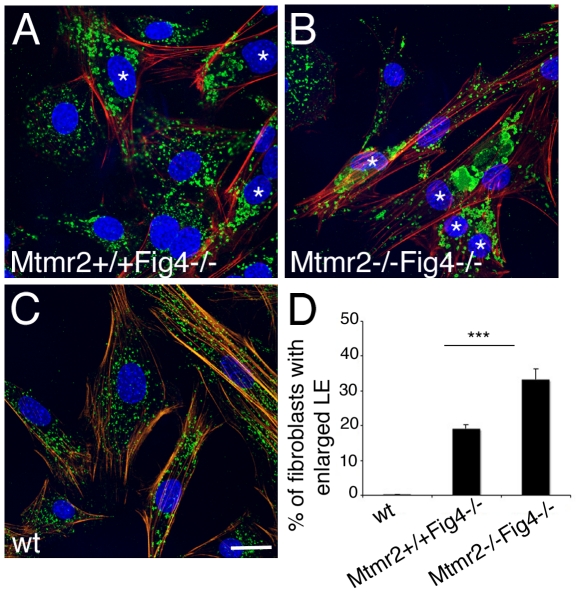
Enlarged late endosomal compartment in primary fibroblasts from Mtmr2+/+Fig4−/− and Mtmr2−/−Fig4−/− mutant mice.(A–C) The number of fibroblasts carrying enlarged late endosomal/lysosomal compartment (LAMP1 positive, green) is significantly increased in Mtmr2−/−Fig4−/− (B) as compared to (A) Mtmr2+/+Fig4−/−. In red is phalloidin which stains actin filaments. Blue, DAPI. The quantification in (D) was made by counting cells established from three animals per genotype. n = 526 on 17 coverslips for Mtmr2+/+Fig4−/−; n = 583 cells on 20 coverslips for Mtmr2−/−Fig4−/−; P = 0.000079; confocal microscopy analysis. Asterisks mark cells carrying enlarged late endosomal compartments. Bar in (A–C) is 25 µm.